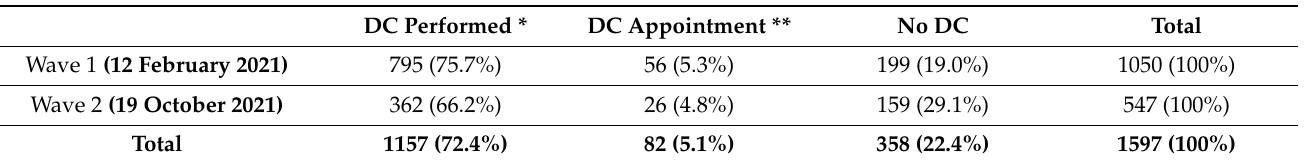
Table 2. Self-reported DC status at the time of the survey (according to survey waves), in absolute numbers and